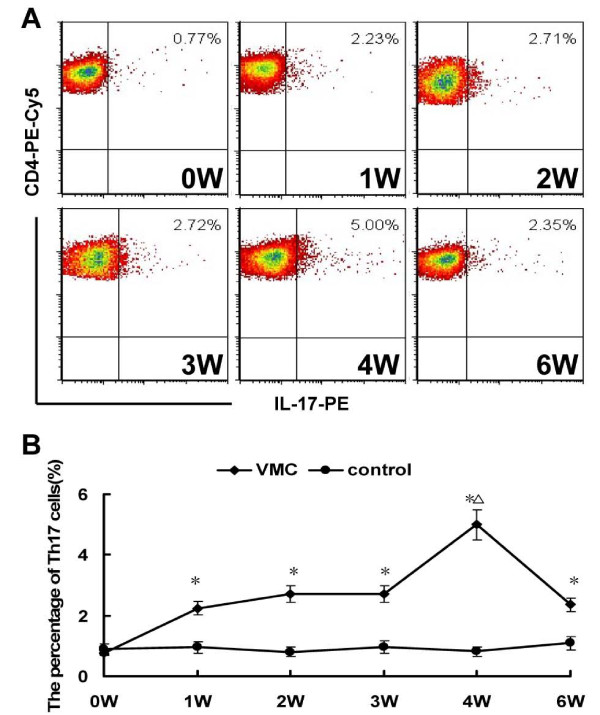
Th17 frequencies in VMC mice. A. Representative pictures of CD4+IL-17+ Th17 cells in VMC mice. Numbers in the upper right quadrants indicate the mean percentages of CD4+ Th17 cells in VMC mice. B. The results of the Th17 cells statistical analysis. ΔP < 0.01, versus control group. ΔP < 0.05, versus week 0, 1, 2, 3, and 6 VMC mice.